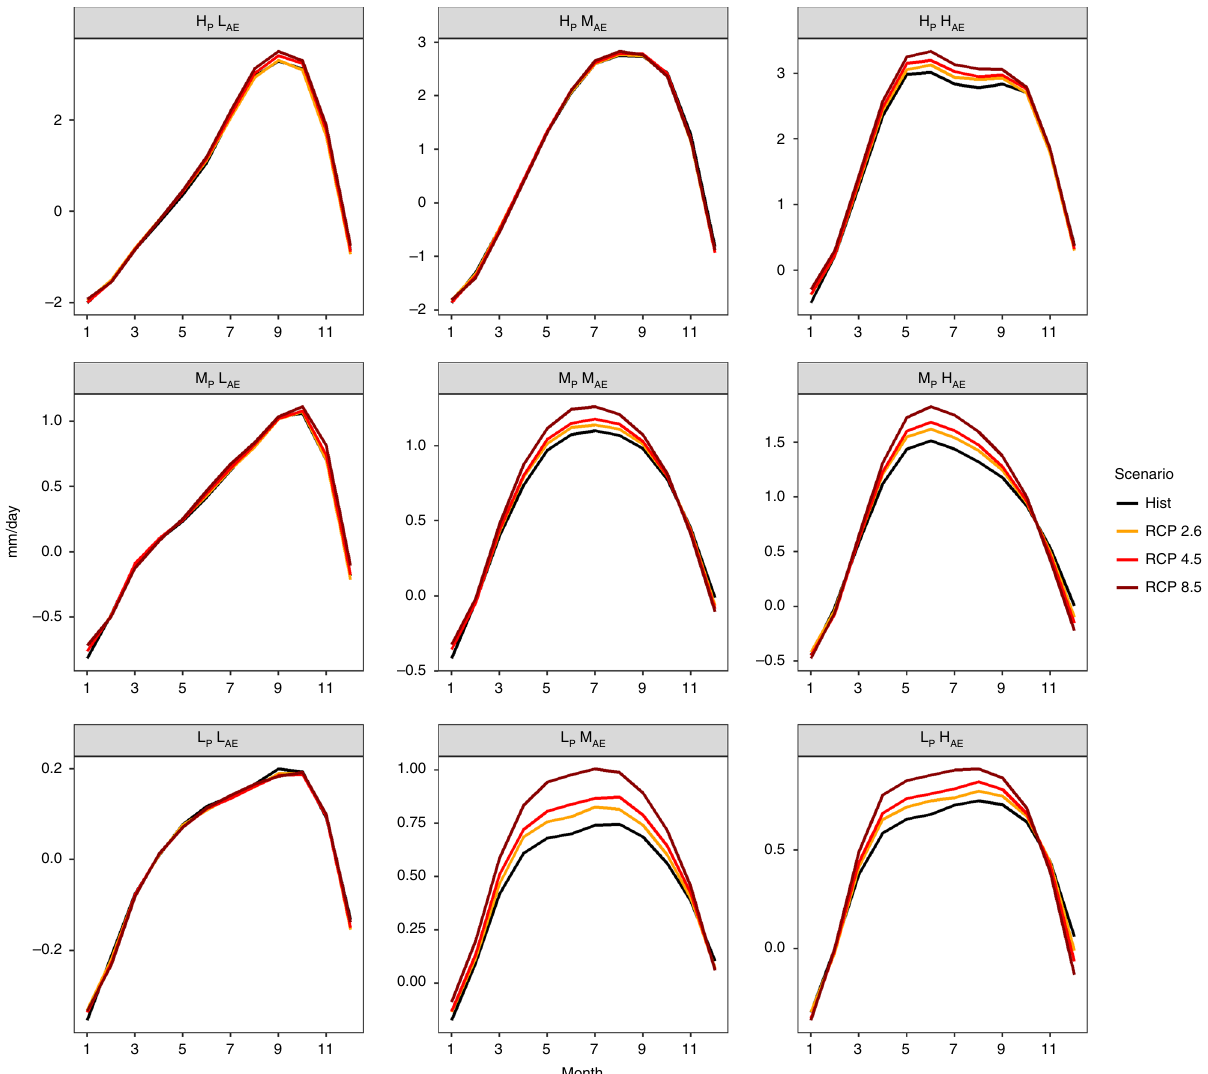
Fig. 3 Future monthly water availability. a BMA ensemble monthly projected (RCP 2.6, RCP 4.5, and RCP 8.5) of available water (2070 – 2099) and historical (1971 – 2000) scenarios. Where, H, M, and L abbreviate high moderate and low values, respectively. Whereas, apportionment entropy is abbreviated as AE and annual precipitation as